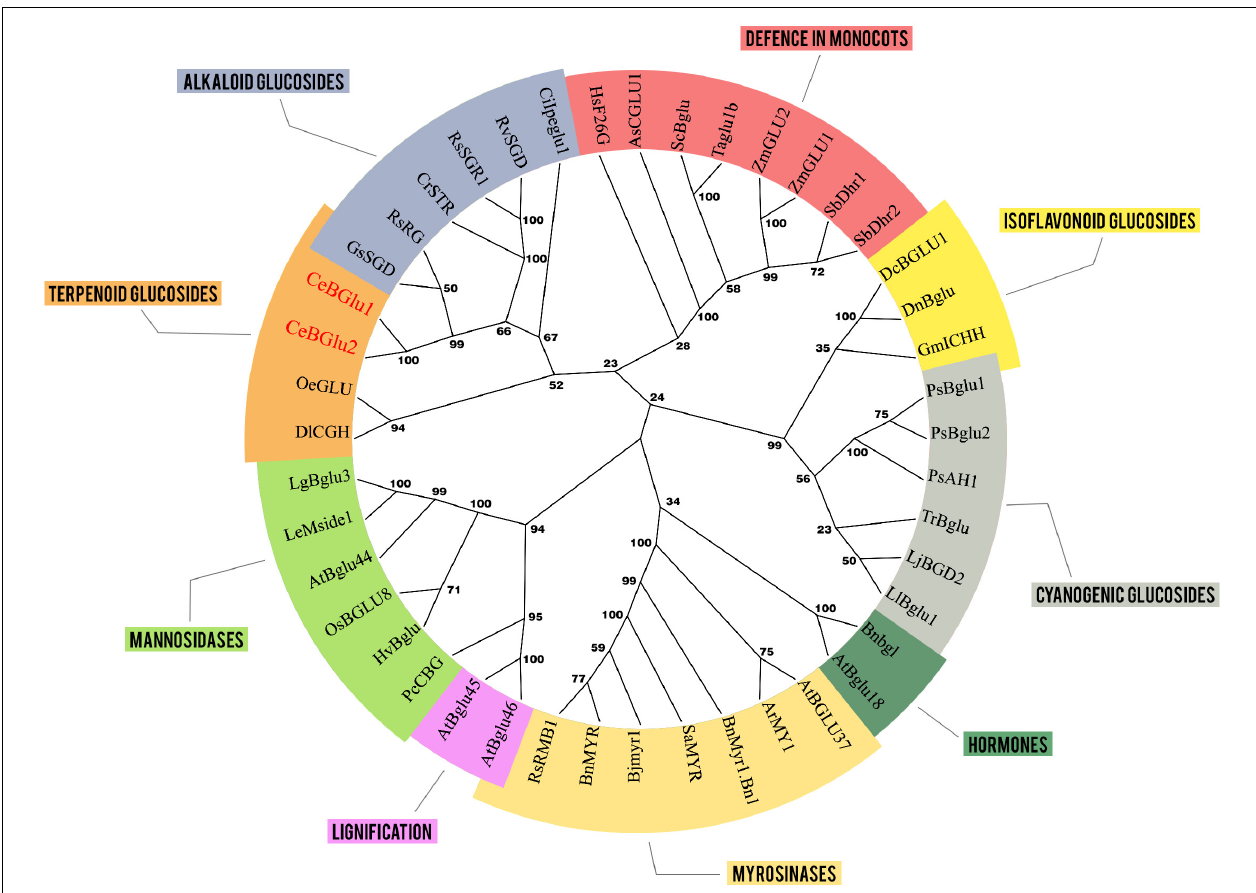
FIGURE 4 | The neighbor-joining tree generated using MEGA X (Version 10.2.6) with a bootstrap of 1,000 replicates, illustrating the phylogenetic relationship of the Ce BGlu1 and Ce BGlu2 candidates (red letters) relatively to homologous genes from various plant species (refer to Supplementary Table 2 for a list of plant protein sequences used for phylogenetic analysis and their corresponding accession numbers). The optimal tree is shown. The percentage of replicate trees in which the associated taxa clustered together in the bootstrap test (1,000 replicates) are shown next to the branches. Groups of enzymes with experimentally defined functions are labeled with different